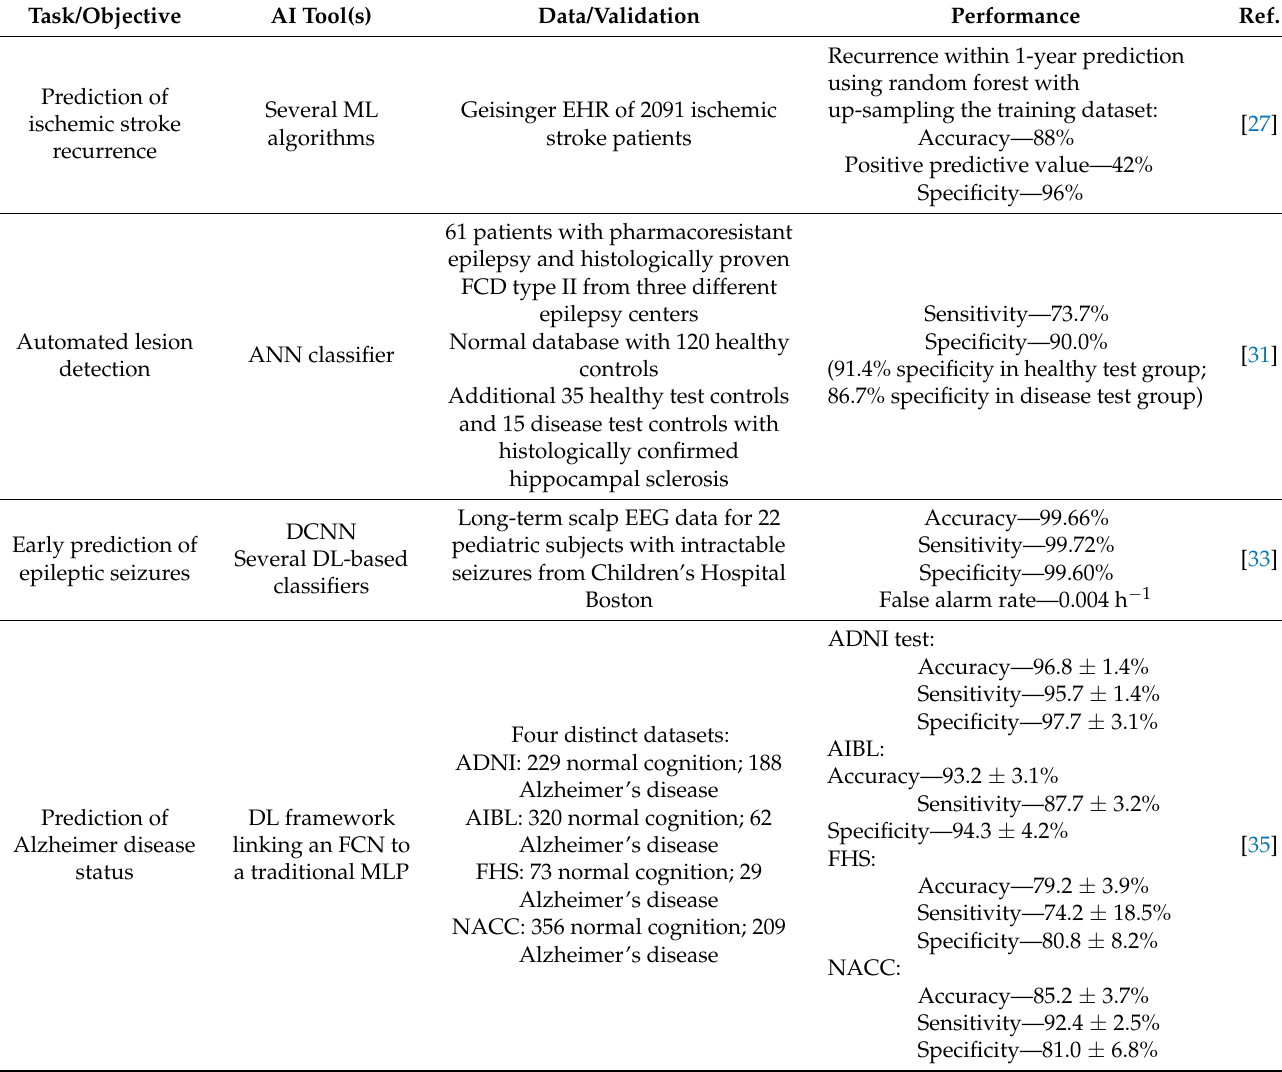
Table 3. Summary of the recent AI studies in